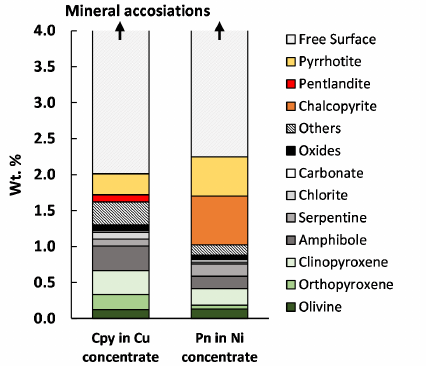
Figure 7. Mineral association in the concentrates.